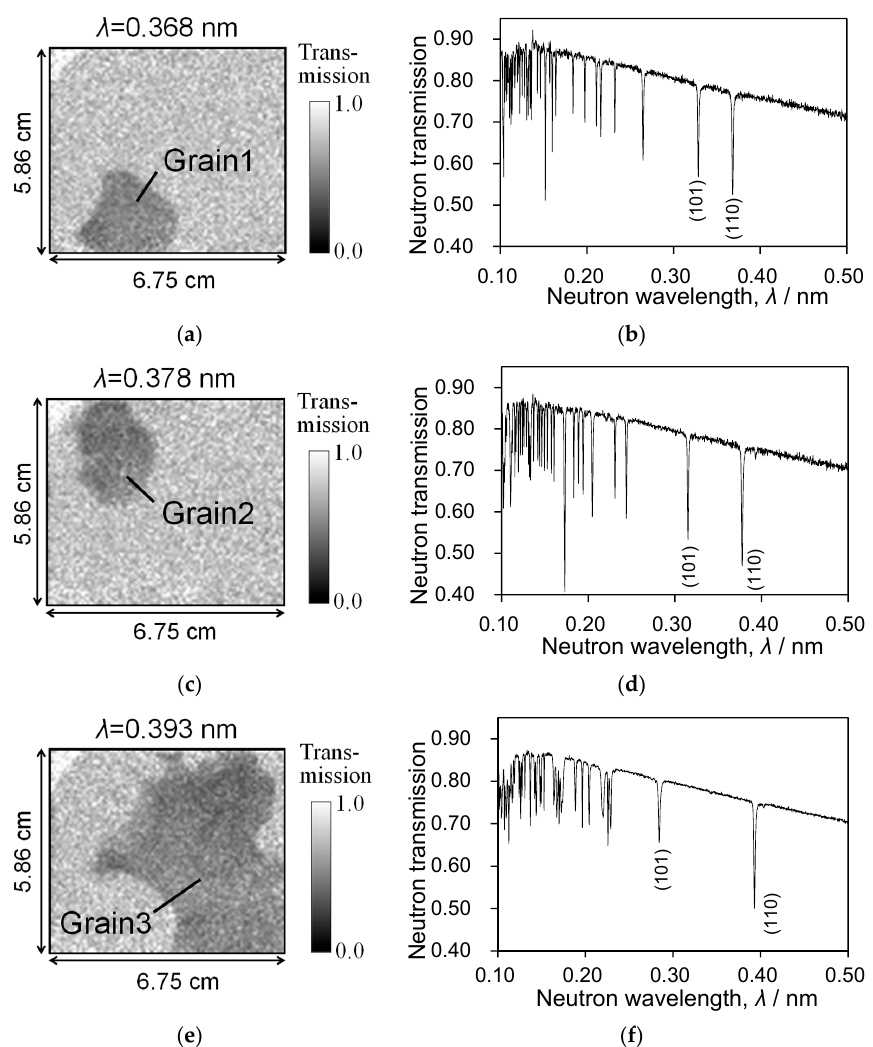
Figure 4. ( a ) Neutron transmission image at the wavelength of 0.368 nm. ( b ) Neutron transmission spectrum of Grain 1. ( c ) Neutron transmission image at the wavelength of 0.378 nm. ( d ) Neutron transmission spectrum of Grain 2. ( e ) Neutron transmission image at the wavelength of 0.393 nm. ( f ) Neutron transmission spectrum of Grain 3.